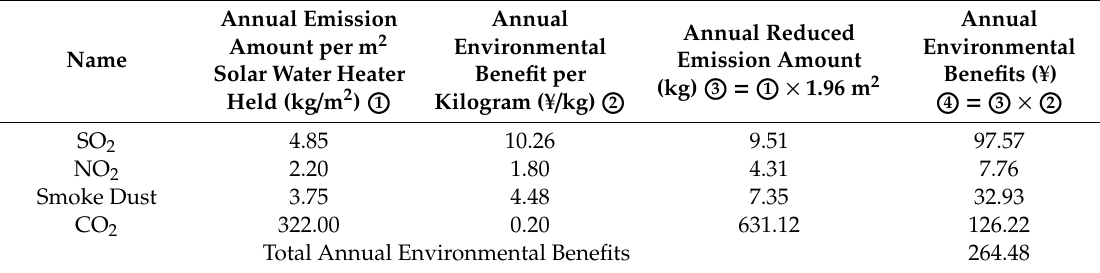
Table 7. Total annual environmental benefits of using a solar water heater.